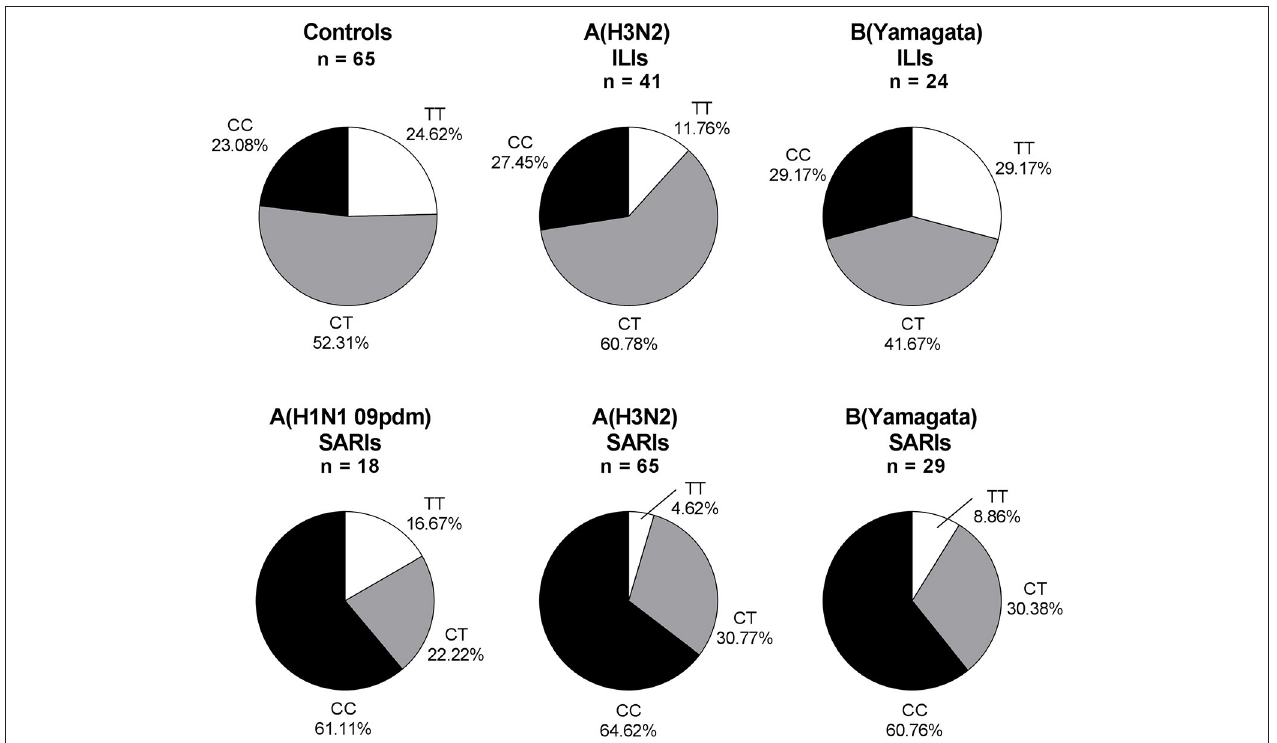
FIGURE 2 | IFITM rs12252 genotypic frequencies in IVI cases with different viral type. ILI cases and SARI cases. ILI, influenza-like illness, SARI, Severe Acute Respiratory Infection, IVI, influenza virus infection. Five influenza A(H1N1 09pdm) virus-infected ILIs (including one CC genotype and four CT genotype), one influenza B(Victoria) virus-infected ILI (TT genotype) and two influenza B(Victoria) virus-infected SARIs (one TT genotype and one CT genotype) were not